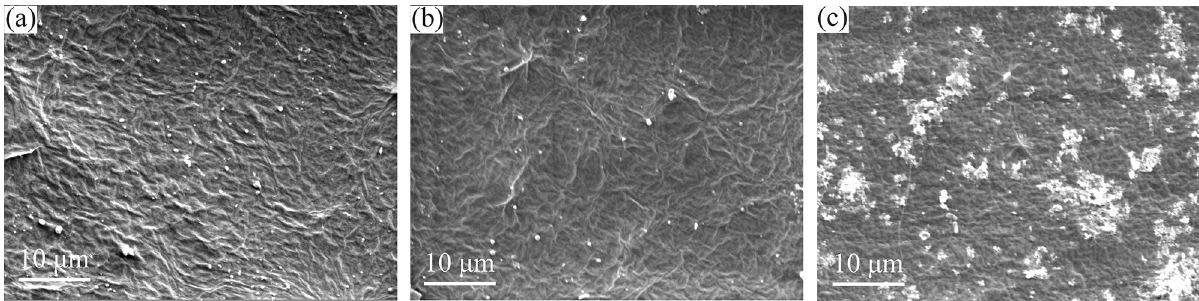
Fig. 8 Surface morphology of membranes after PV test. a c-GO-PEI (6.36 ppb Hg wastewater); b c-GO-PEI (9.4 ppb Hg wastewater); c pristine GO membrane (9.4 ppb Hg wastewater) Table. 2 Mass balance calculation of Hg-containing wastewater test Hg concentration Mass of feed /g in feed /ppb